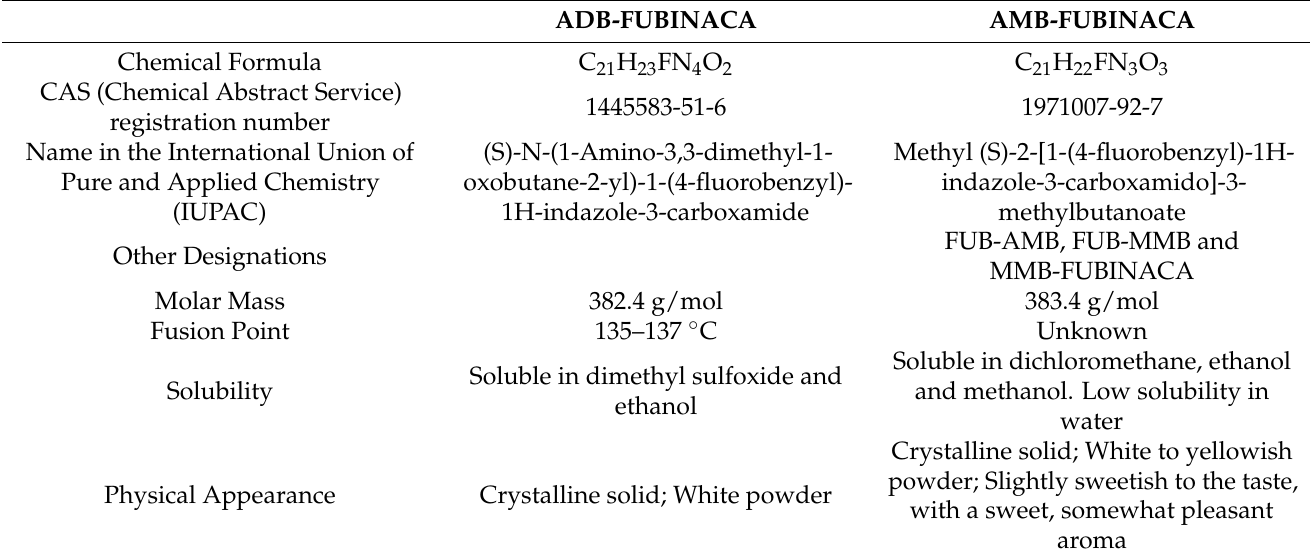
Table 1. Physicochemical properties of ADB-FUBINACA and AMB-FUBINACA [12,20,29,35–37]. ADB-FUBINACA